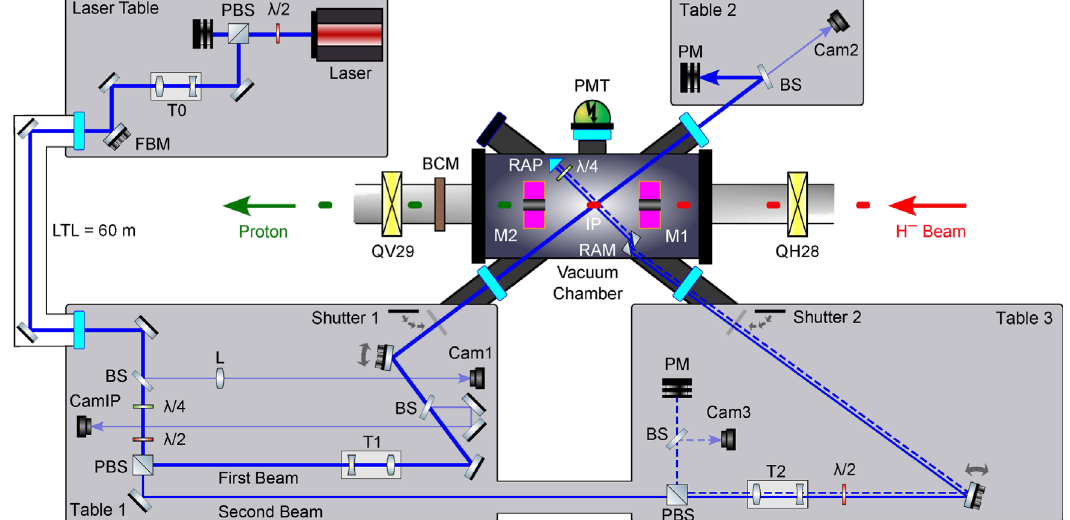
FIG. 9. Overview of the laser transport system and the experimental setup around the laser stripping chamber in the accelerator tunnel. PBS, polarized beam splitter; FBM, feedback mirror; T0 – T2, telescopes; LTL, laser transport line; BS, beam splitter; PMT, photomultiplier tube; M1 and M2, magnets; QH28 and QV29, quadruple magnets; BCM, beam current monitor; IP, interaction point; RAP, right angle prism; RAM, right angle mirror; λ = 2 , half-wave plate; λ = 4 , quarter-wave plate. The dashed lines represent the retroreflected light out of the vacuum chamber from the second beam. laser table, and the local optical table in tunnel is shown in Fig. 9. The laser beam control optics in the RSB laser table